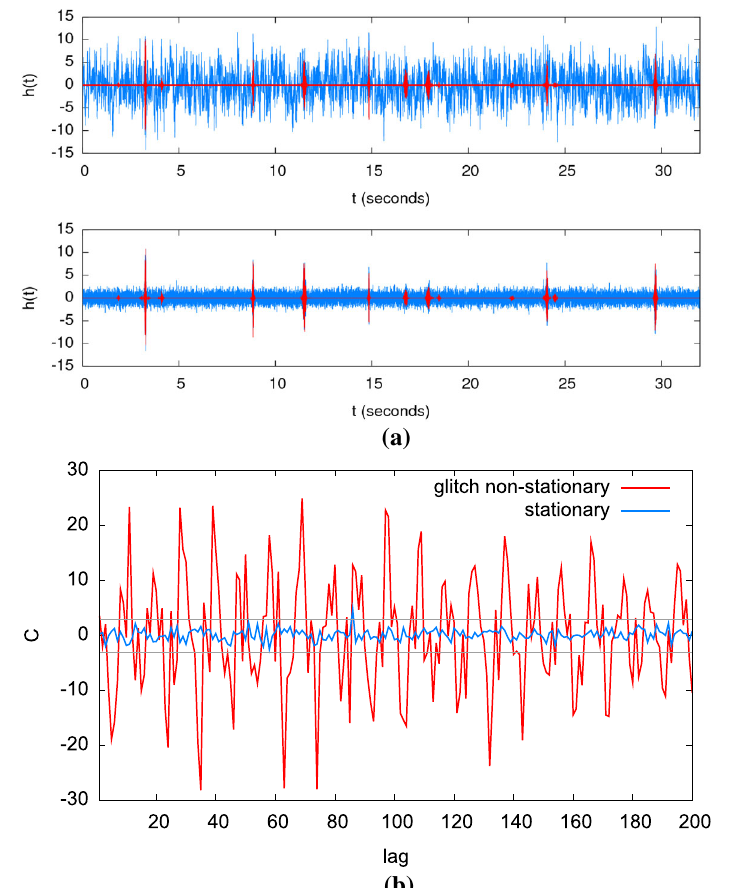
Fig. 73 Panel a shows simulated stationary AR ( 1 ) data with non-stationary noise transients, or glitches, highlightedin red .The upperpanel istherawdata,whilethe lowerpanel hasbeenwhitenedbytheestimated amplitude spectral density. Panel b shows the autocorrelation for the stationary AR ( 1 ) data without glitches in blue , and with glitches in